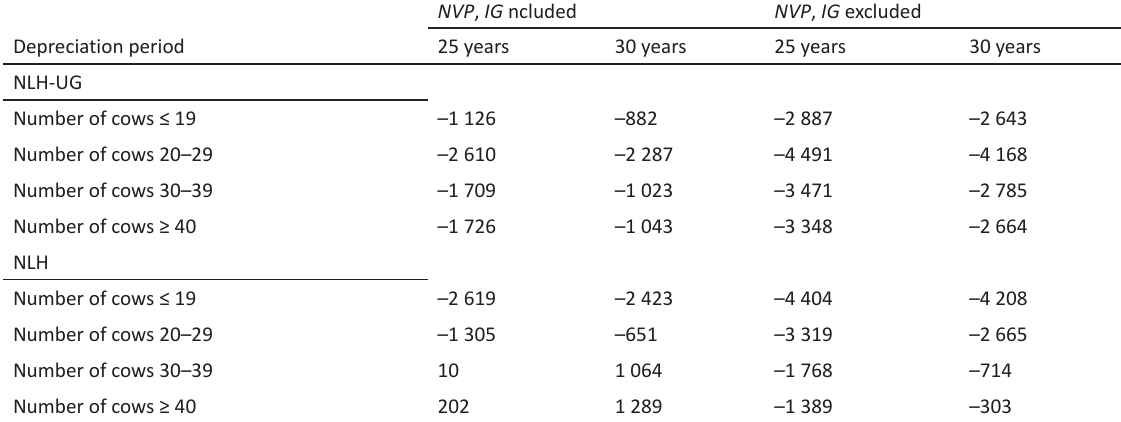
Table 4. NVP for NLH-UG (upper half) and NLH (lower half) with and without IG . The figures are averages for herds of different sizes and two different depreciation periods, 25 and 30 years. All figures are in 1000